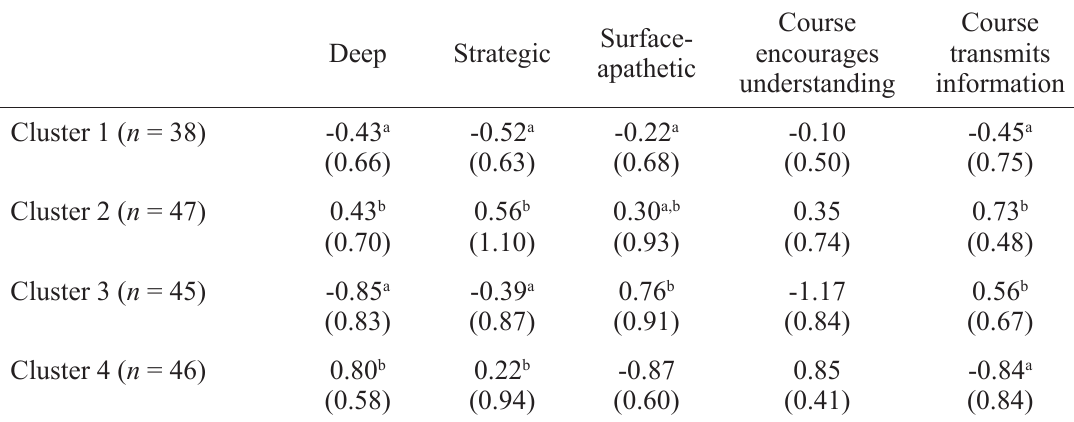
Mean Standardised Scores (and Standard Deviations) of Students in Four Clusters